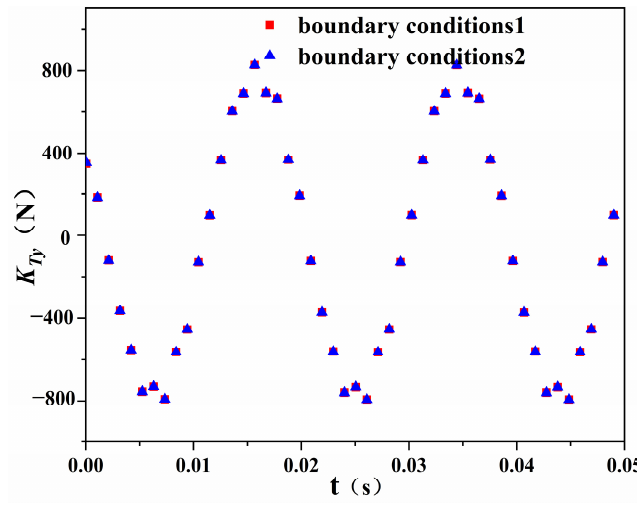
Figure 3. The difference of two boundary conditions.